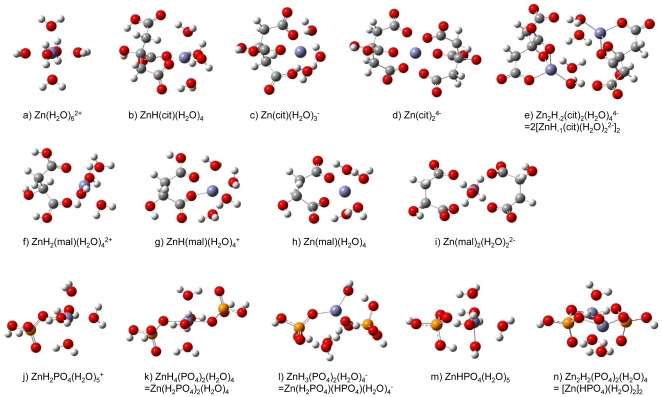
Molecular structures of hydrated Zn2+ and aqueous Zn citrates, malates, and phosphates.Structures are drawn by using GaussView5 (Gaussian Inc.) [14]. Symbols are: Zn (iris), P (orange), O (red), C (gray), and H (white).